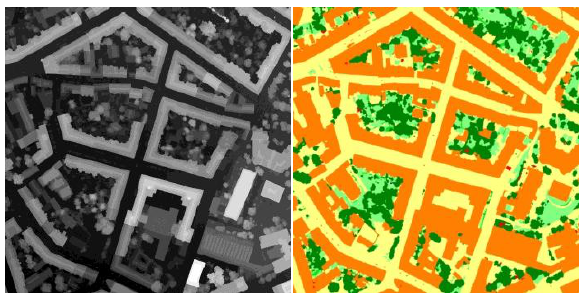
Figure 3. (a) Digital surface model from the test area (b) Classification image (orange: buildings, yellow: sealed surfaces, turquoise: bare earth, light green: grass, dark green: trees, blue: water, unclassified: